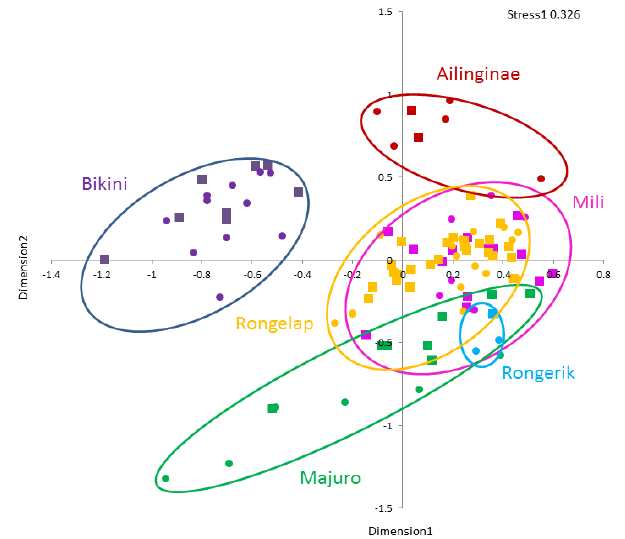
Figure 5. Two-dimensional nMDS of coral assemblages in the Marshall Islands using the Bray-Curtis distance measure. Square symbols represent exposed sites; circular symbols represent protected